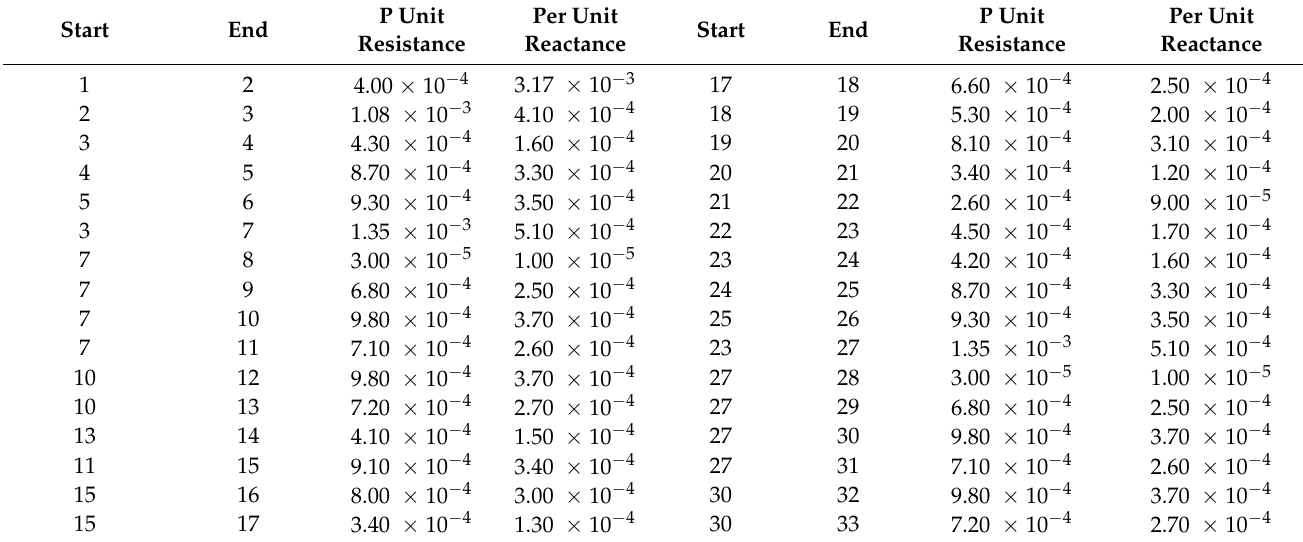
Table 1. LV distribution grid data.